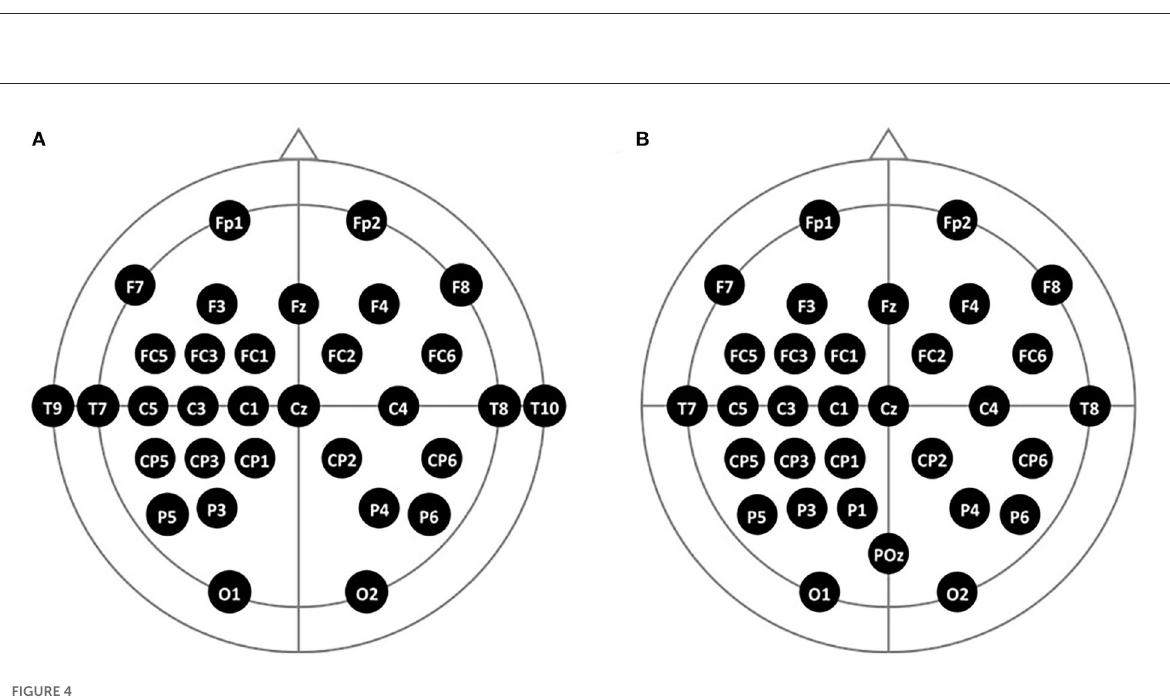
both paradigms for the VEPs, the participants were asked to relax without any movement and to watch the monitor. In each VEP paradigm, the monitor displayed a top-view image of the